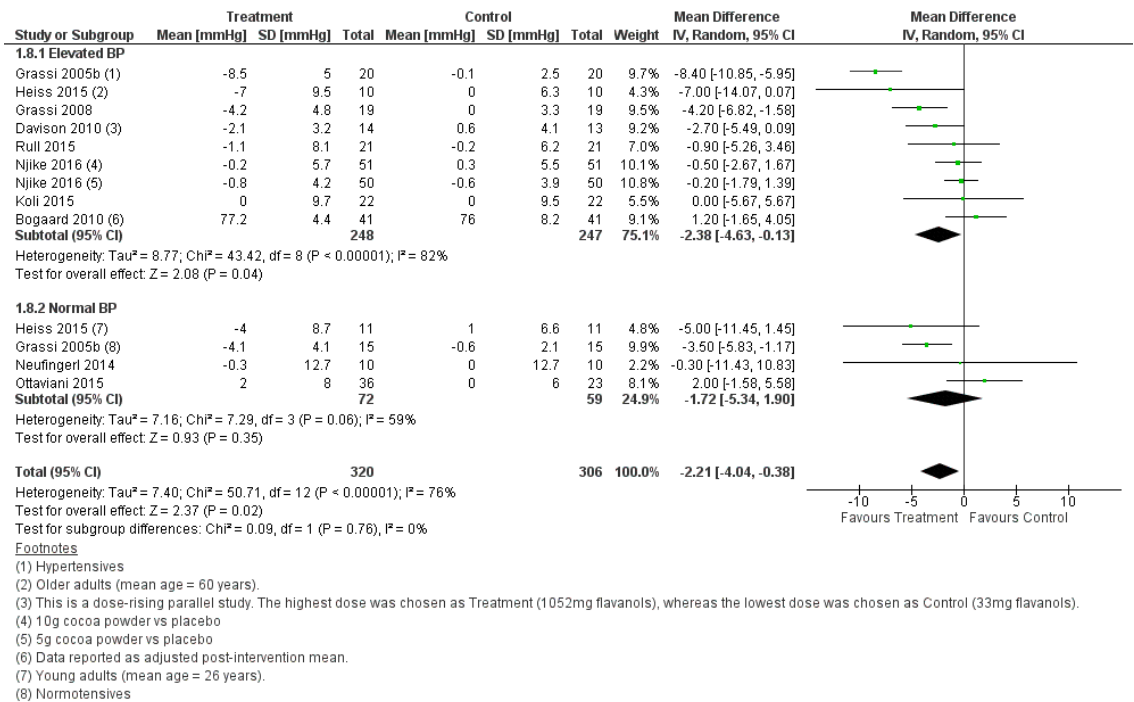
Figure 6. Forest plot showing the pooled effect of cocoa consumption on 24-h systolic BP.